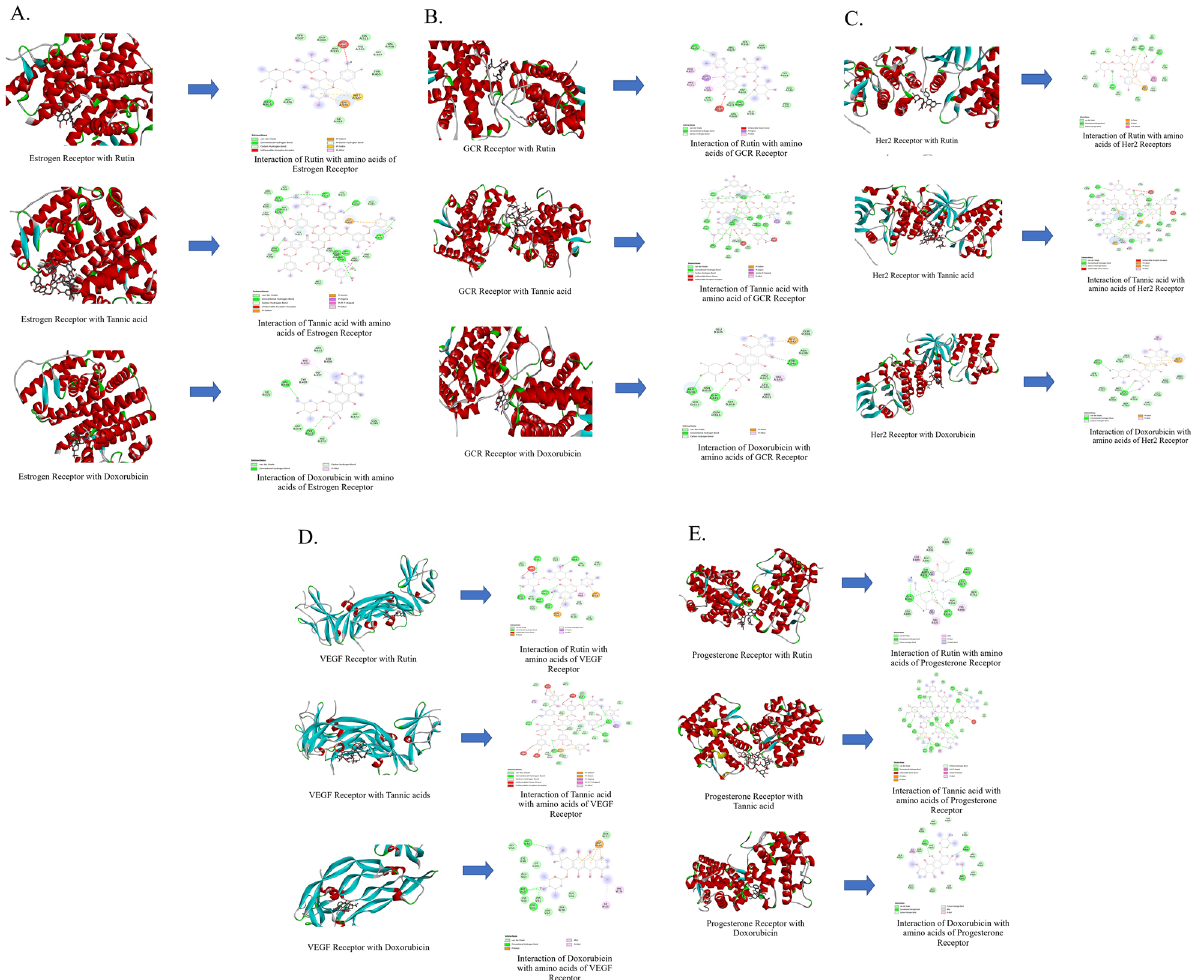
Figure 8. Molecular docking of Rutin, Tannic acid and their interaction with amino acids of ( A ) Estrogen receptor, ( B ) GCR receptor, ( C ) HER2 receptor, ( D ) VEGF receptor and ( E ) Progesterone receptor of cervical